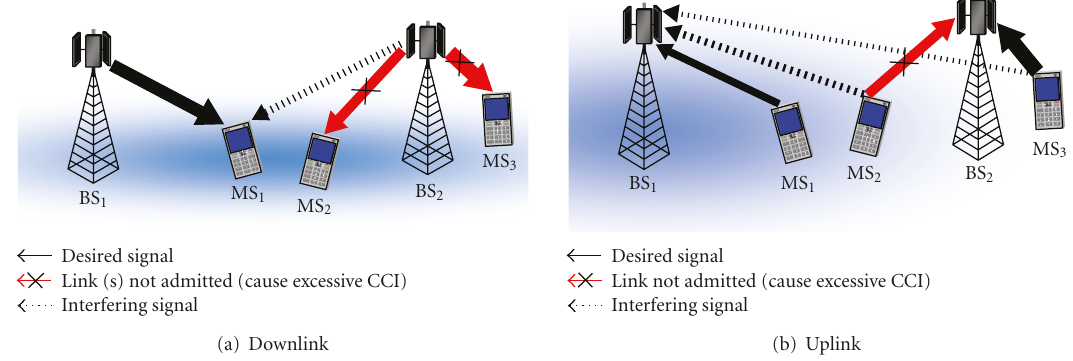
Figure 2: BB signalling applied to cellular system. The arrows depict the direction of desired and interfering signals and their relative strength is indicated by their width. The strength of BB signal is indicated by the darkness of the shade around the vulnerable